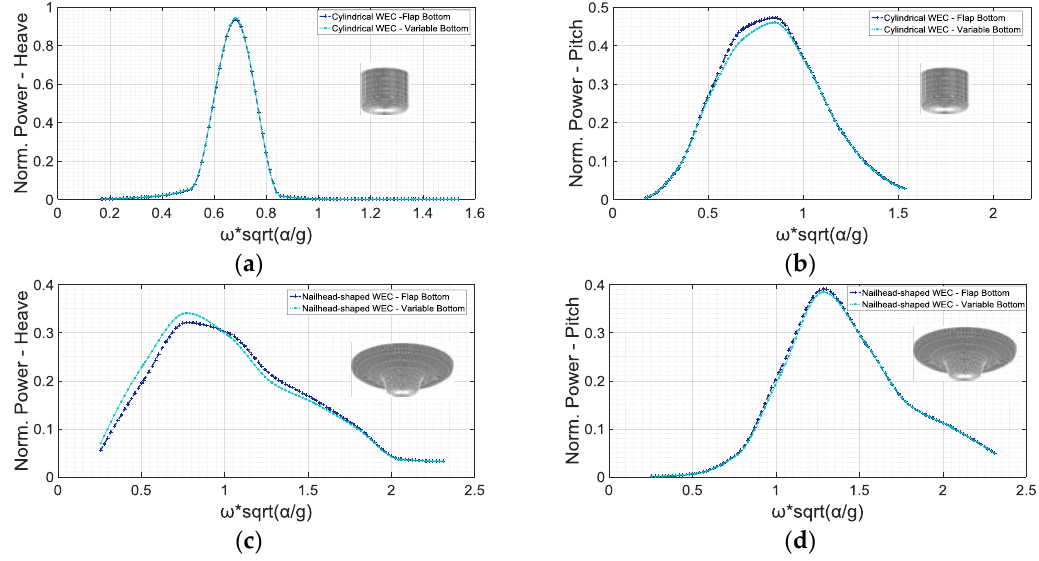
Figure 9. Normalized power output over flat and variable bottom topography ( h 1 = 1.2 m, h 3 = 0.8 m, α bot = 0.5) using the optimized PTO. Cylindrical WEC in ( a ) heave mode and ( b ) pitch mode, and nailhead-shaped WEC in ( c ) heave mode and ( d ) pitch mode.